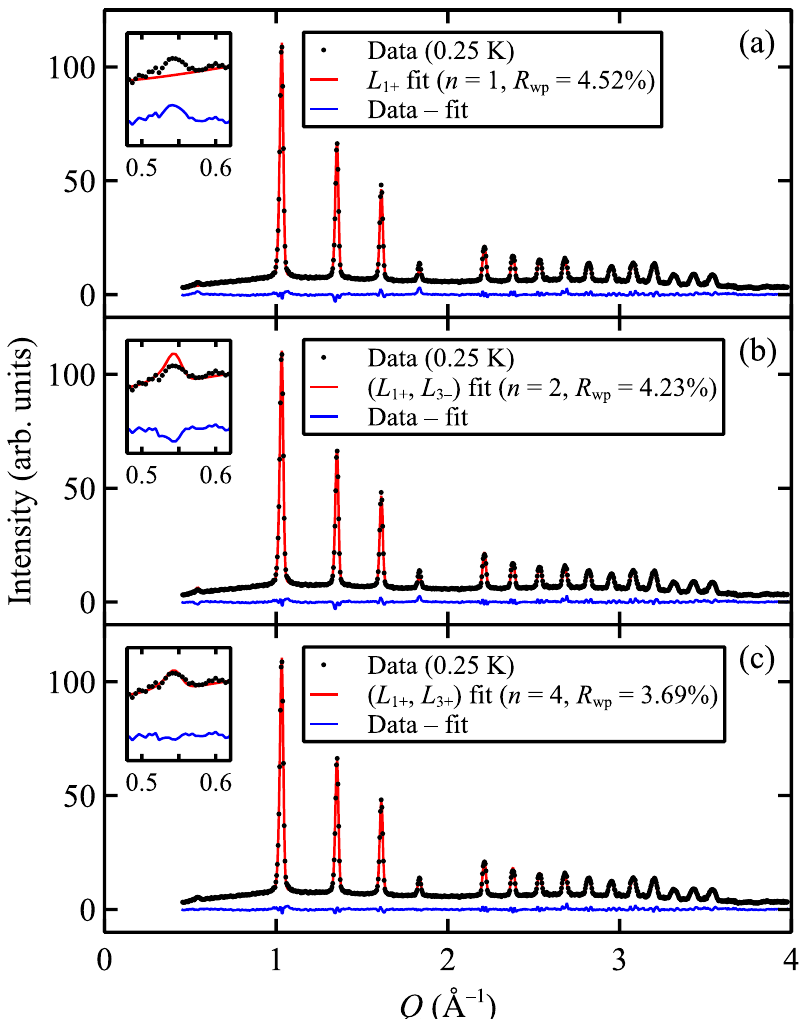
Fig. 3 Powder neutron-diffraction data and magnetic Rietveld re fi nements. Experimental powder neutron-diffraction data (from ref. 28 , λ = 2.42 Å) in the low-temperature phase (0.25 K) and Rietveld fi ts for a the L 1 + irrep, b the ( L 1 + , L 3 − ) irrep pair, and c and the ( L 1 + , L 3 + ) irrep pair. Experimental data are shown as black points, fi ts as red lines, and data — fi t as blue lines. For each model, the number of free parameters (magnetic distortion modes) n and the goodness-of- fi t metric R wp are shown. The insets show the ð 1 21 21 expanded